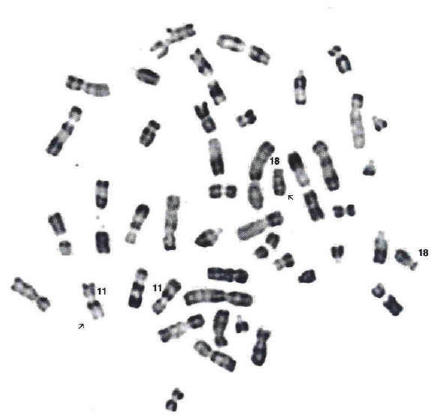
Figure 3: The karyotype of the malignant bone marrow cells at presentation that shows the t(11;18)(q21;q21).